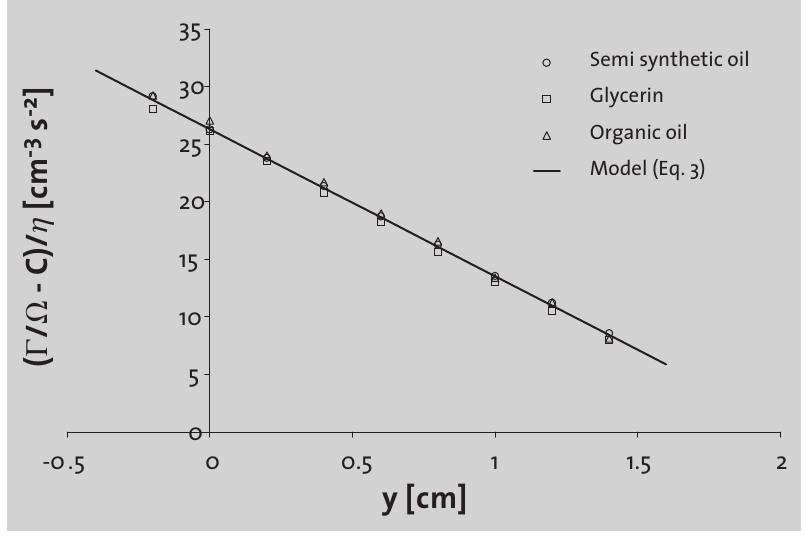
(2) Figure 2: Ratio ( G / W - C)/ h as